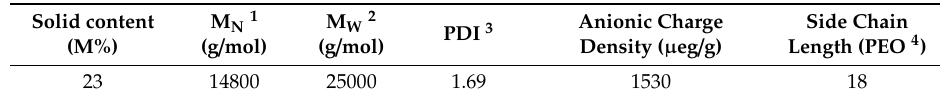
Table 2. Chemical data of the